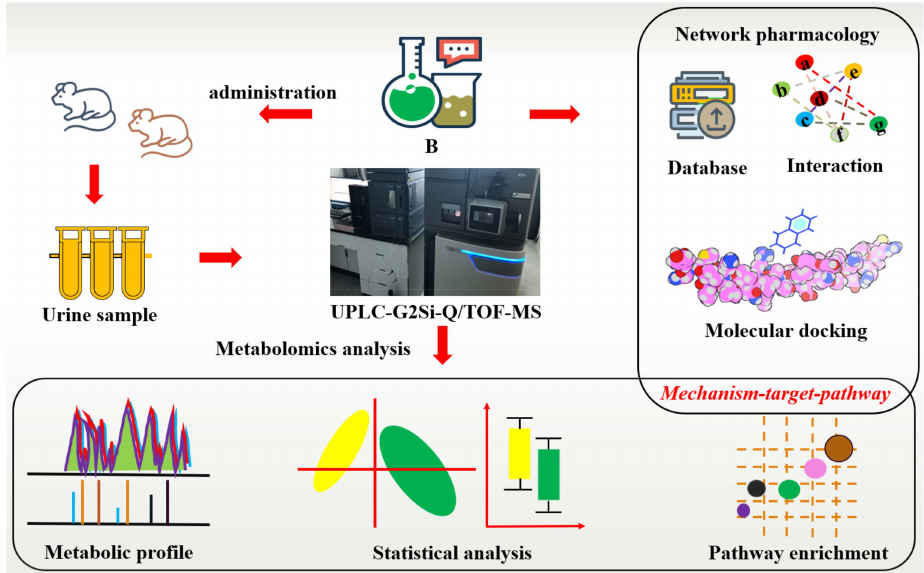
Figure 1. Flow chart of mass spectrometry-based metabolomics combined with network pharmaco- logical analysis of the mechanism of action of Paeoniae Radix Alba in rheumatoid